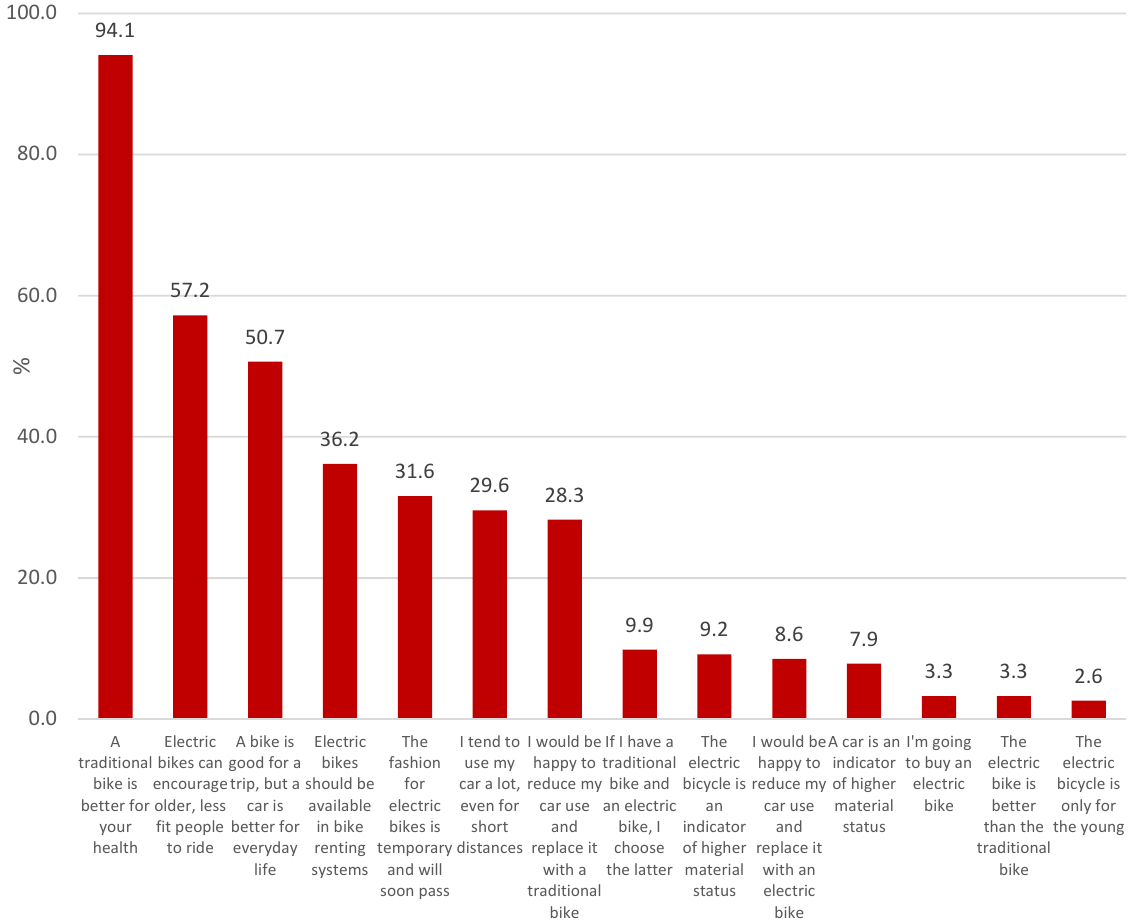
Figure 5. Structure of answers to the question: “Please tick the statements with which you agree”. Source: Own elaboration on the basis of the questionnaire survey.